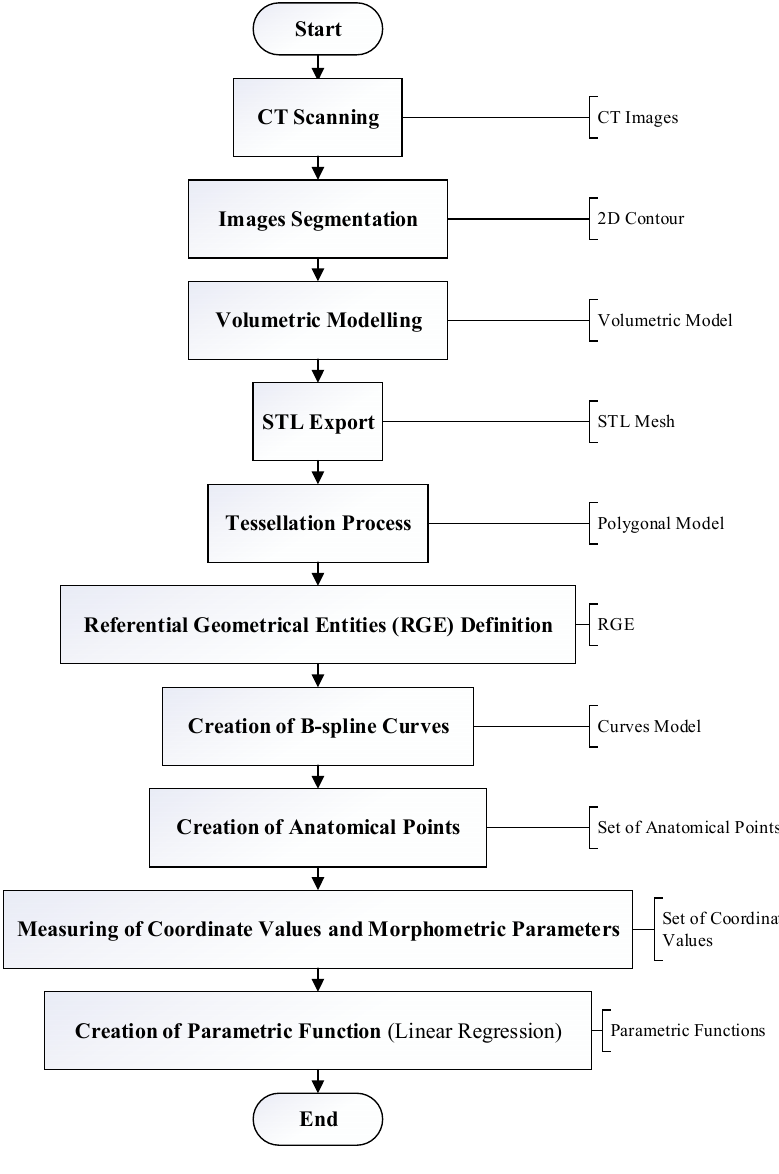
Figure 1. Flowchart of the Method of Anatomical Features (MAF).